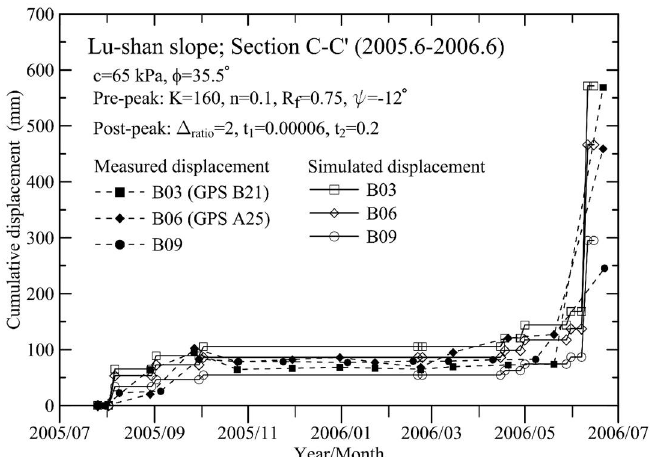
Figure 22. Comparison between slope displacements measured at various locations and those calculated using c = 65 kPa, ϕ = 35.5 ◦ , K = 160, n = 0.1, R f = 0.75 and Ψ = − 12 ◦ as well as taking into account post-peak soil strength softening.